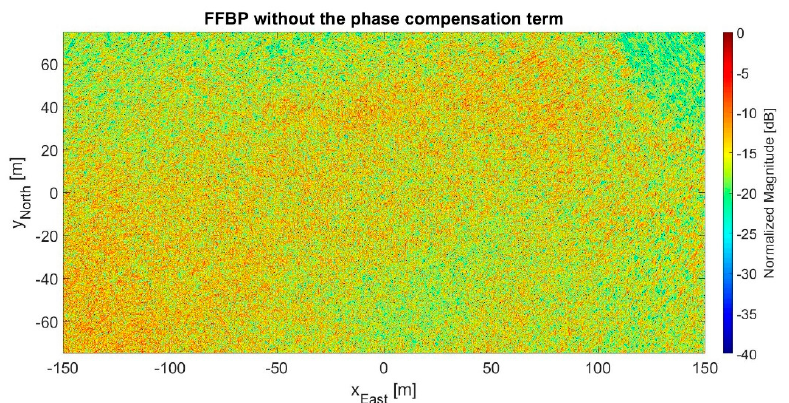
Figure 19. 2D output image processed by the FFBP algorithm without the phase